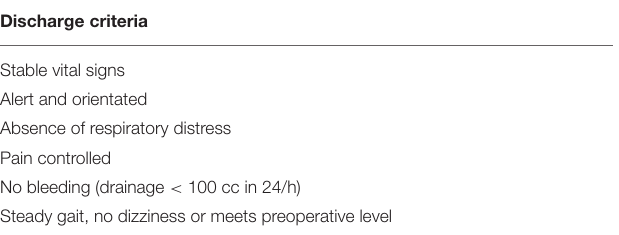
TABLE 1 | Discharge